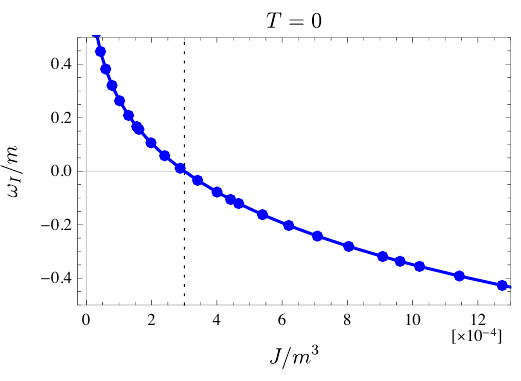
Figure 8 . ω I /m of the pure-imaginary mode as a function of J/m 3 at T = 0 . The points on the curve denote numerical data. The vertical dotted line indicates J (1) first turning point.